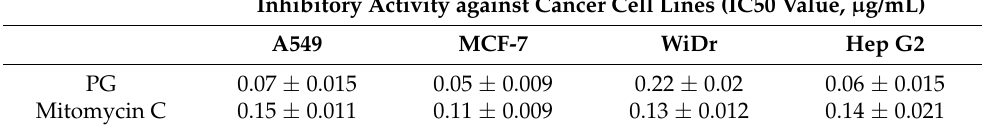
Table 4. The anticancer effect of